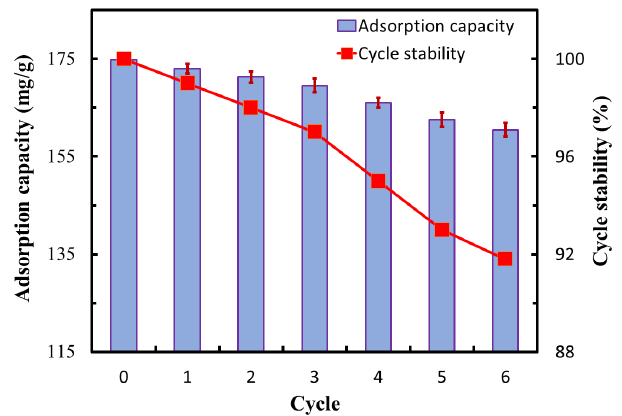
Figure 11. The adsorption capacity and cycle stability of the GO ‐ CNT/AC composites [Conditions: adsorbent amount = 100 mg, MB solution amount = 100 mL, MB solution concentration = 200 mg/L, pH = 7, adsorption time = 300 min, CNT concentration = 3 mg/mL].